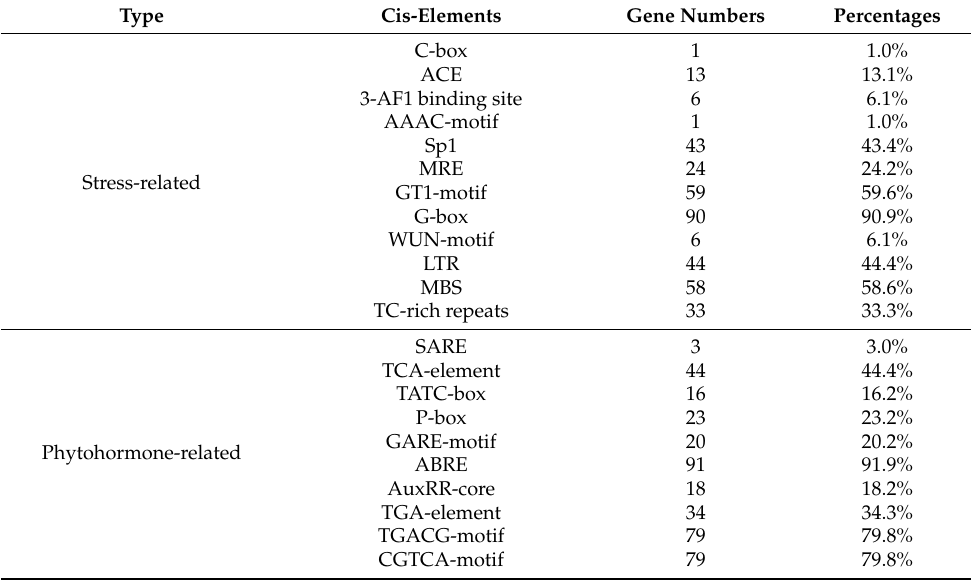
Table 1. Statistical analysis of the cis-elements in 2000 bp regions upstream of Os2R_MYB